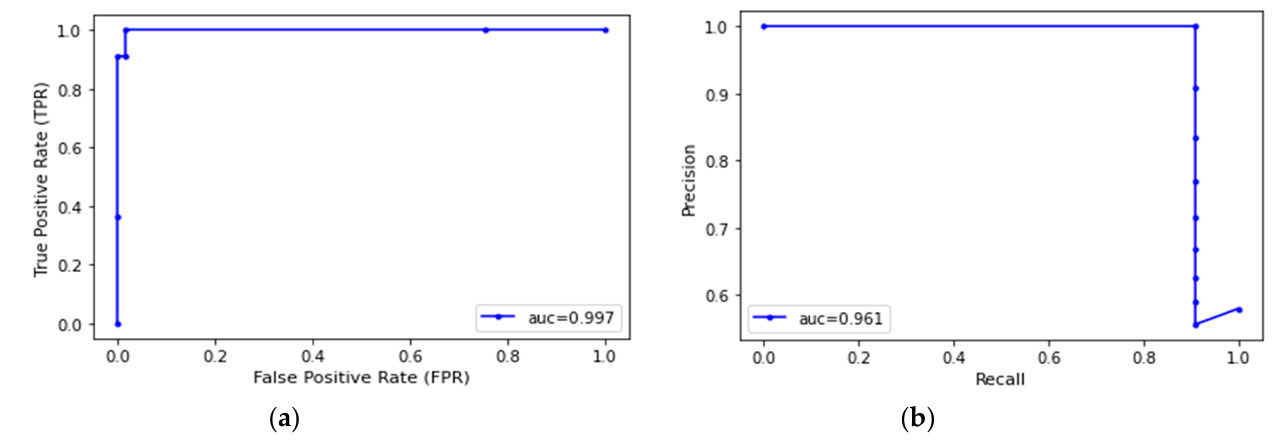
Figure 8. ROC and PR curves of the DCLOP approach. ( a ) ROC curve; ( b ) PR curve.